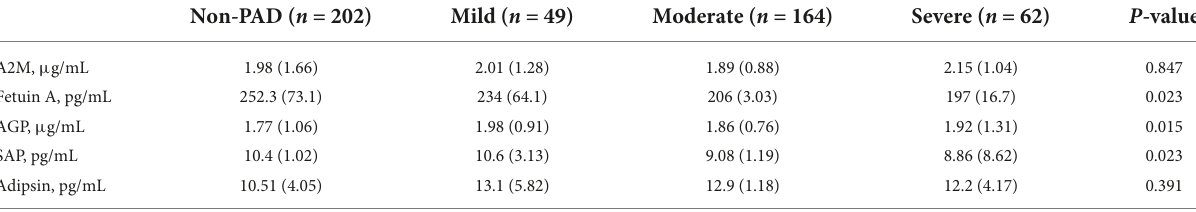
TABLE 2 Levels of inflammatory protein levels among patients with and without